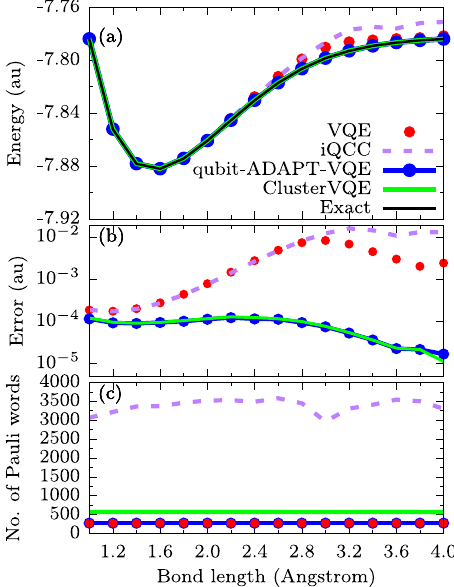
Fig. 2 Potential energy surface of LiH molecule. a GS energy, ( b ) energy error, and ( c ) number of Pauli words in the qubit Hamiltonian of LiH for different bond lengths obtained from different methods. For VQE, one layer of the QUCCSD ansatz is used. One layer of the QUCCSD ansatz is also used as the operator pool for the other